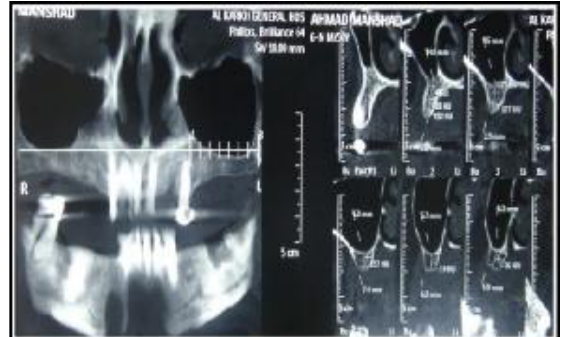
Figure 1: Pre-Operative Medical CT Scan Measurements Show the Height and Width of the Planned Implant Site. Surgical Procedure